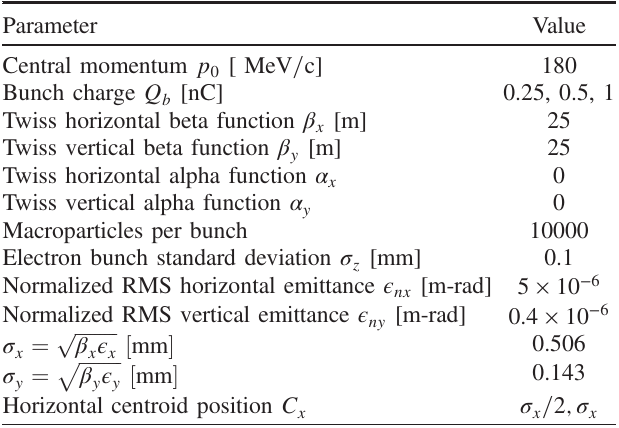
TABLE V. Initial beam parameters used for ELEGANT simu- lations of the XARA design